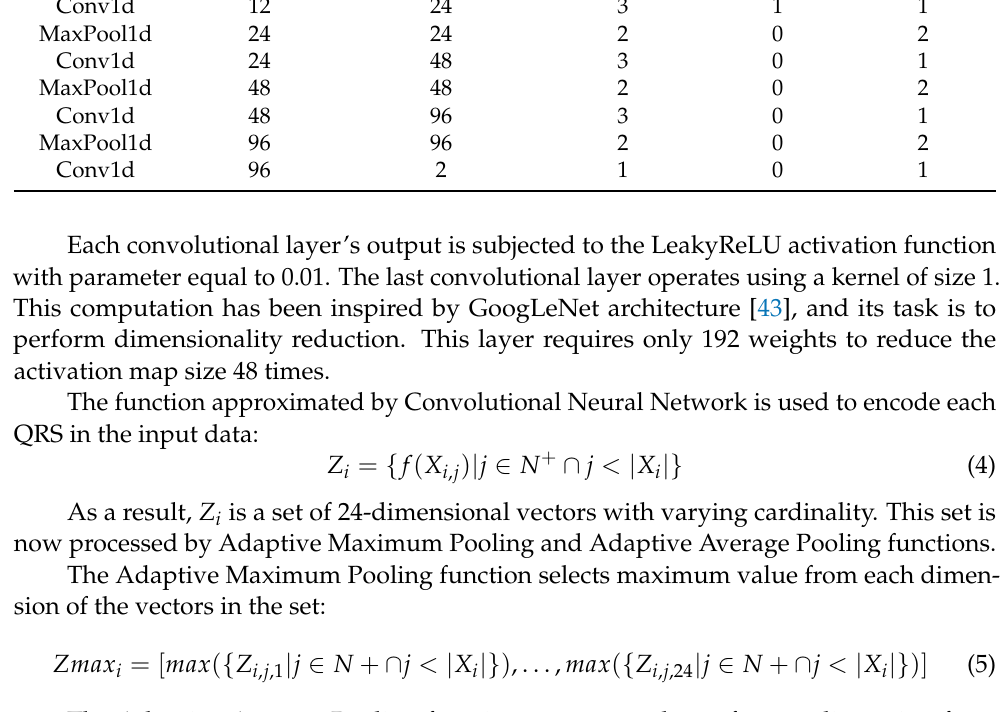
Table 1. The architecture of Deep Convolutional Neural Network encoding one QRS complex. Layer Channels